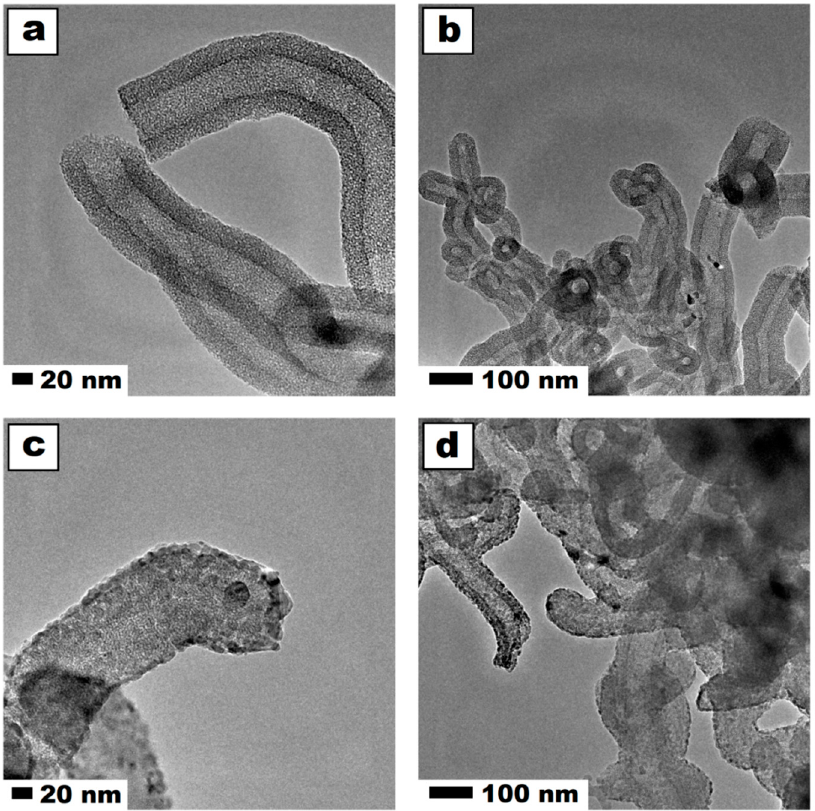
Figure 1. TEM images of pristine ( a , b ) and titanium dioxide functionalized ( c , d ) mesoporous silica nanotubes.